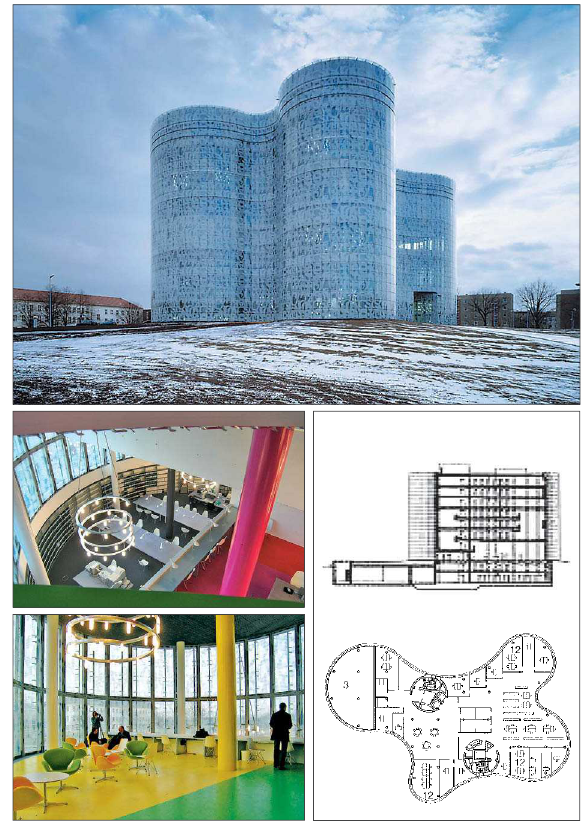
Fig 11. Centre of Information, Communication and Media in Cottbus, Germany